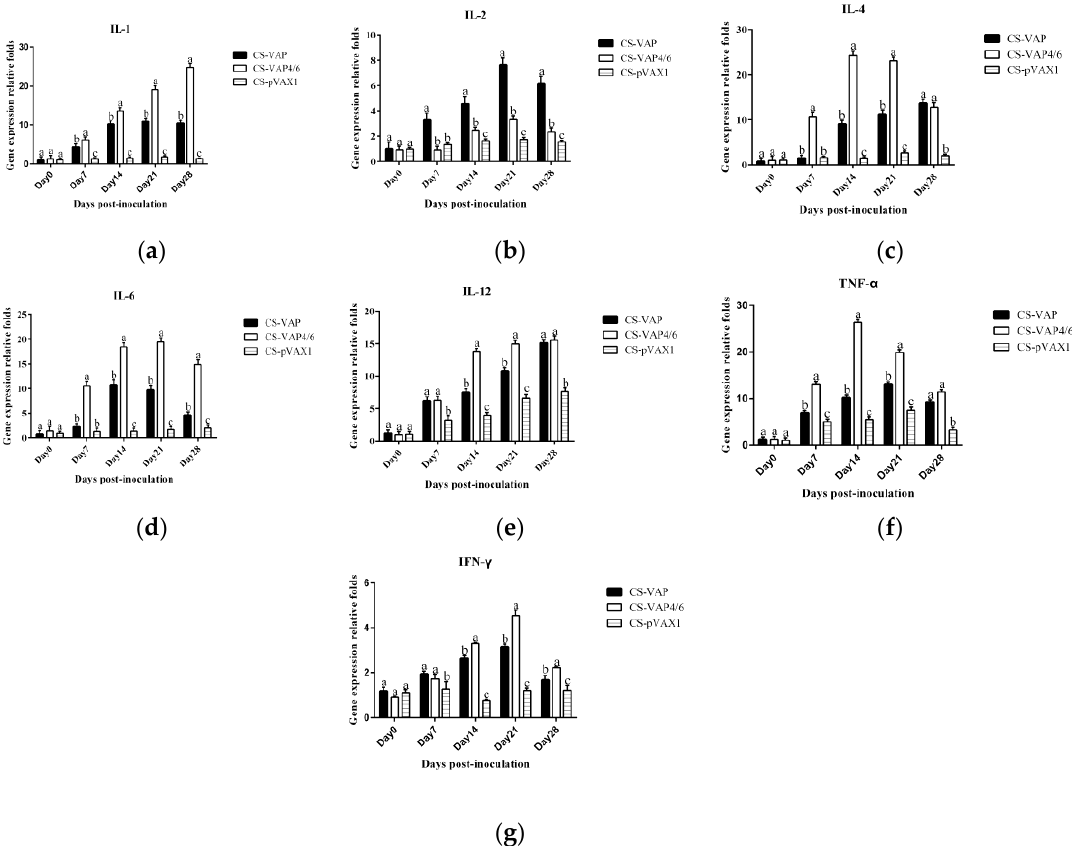
Figure 11. The expression levels of IL-1 ( a ), IL-2 ( b ), IL-4 ( c ), IL-6 ( d ), IL-12 ( e ), TNF-α ( f ) and IFN-γ ( g ) genes. All the gene expression levels of treated groups were significantly increased compared with the control group ( p < 0.05). CS-VAP4/6 had higher expression levels of IL-1, IL-6, and TNF-α from 7 to 28 days ( p < 0.05). Additionally, the group treated with CS-VAP4/6 got higher expression levels of IL-4, IL-12, and IFN-γ genes at 14 and 21 days in comparison with CS-VAP ( p < 0.05). Vaccines 2020 , 8 , x